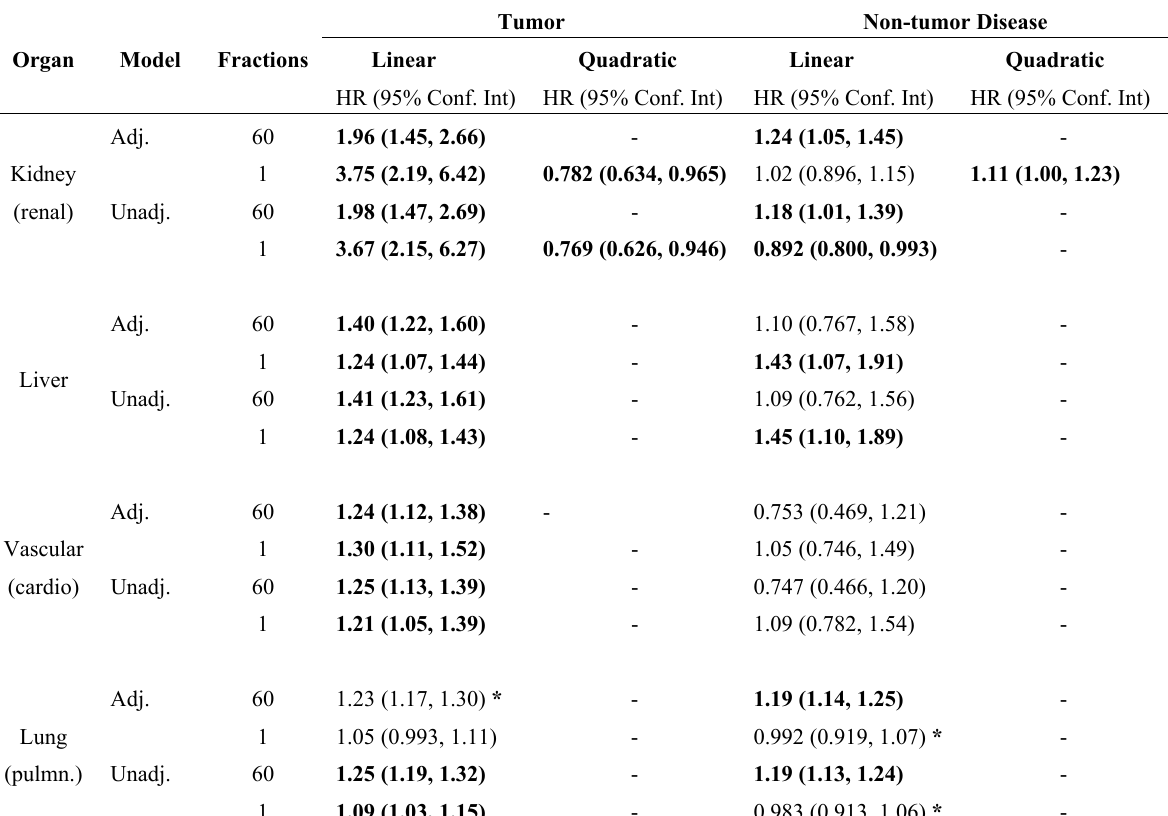
Table 3. Risk of organ system pathologies, neutron radiation.